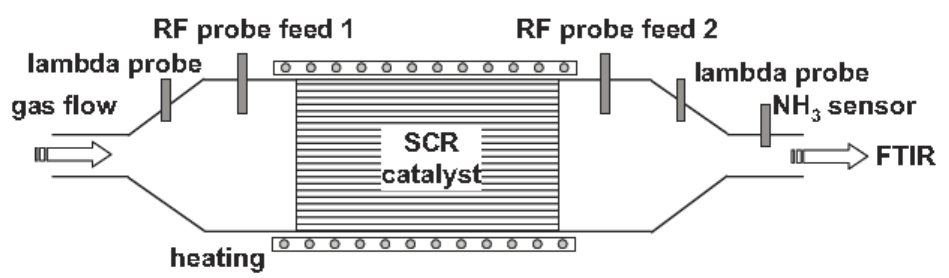
Figure 17. Microwave-based measurement for measuring ammonia loading for selective catalyst reduction (SCR) catalysts (adapted from Reference